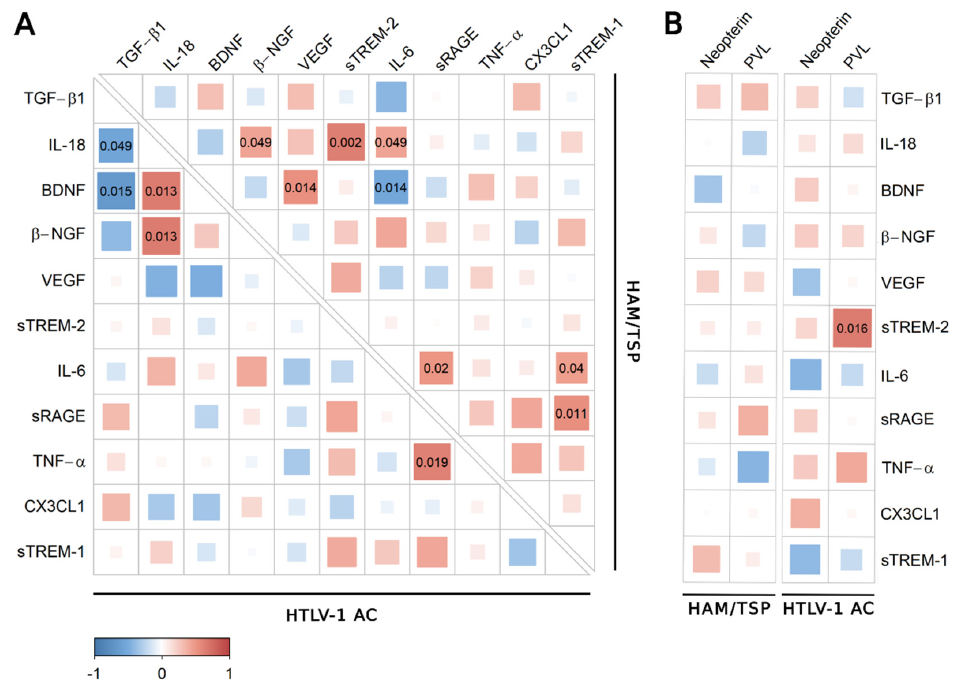
Figure 2. Correlation analysis of biomarkers of neuroinflammation in serum. ( A ) Correlation between TGF- β 1, IL-18, BDNF, β -NGF, VEGF, sTREM-2, IL-6, sRAGE, TNF- α , CX3CL1 (Fractalkine), and sTREM-1 levels in serum samples from asymptomatic HTLV-1 carriers (AC) ( n = 13) and HAM/TSP patients ( n = 20) was performed with Spearman’s rank correlation test. ( B ) The analysis was also performed with the serum neopterin concentration and HTLV-1 proviral load (PVL) in PBMCs from HTLV-1 AC and HAM/TSP patients. Correlation coefficients are indicated by the color intensity, in which positive correlations are shown in red and negative correlations in blue. The size of the squares at intersections between factors represents the p -value, which is shown only for significant associations ( p < 0.05).